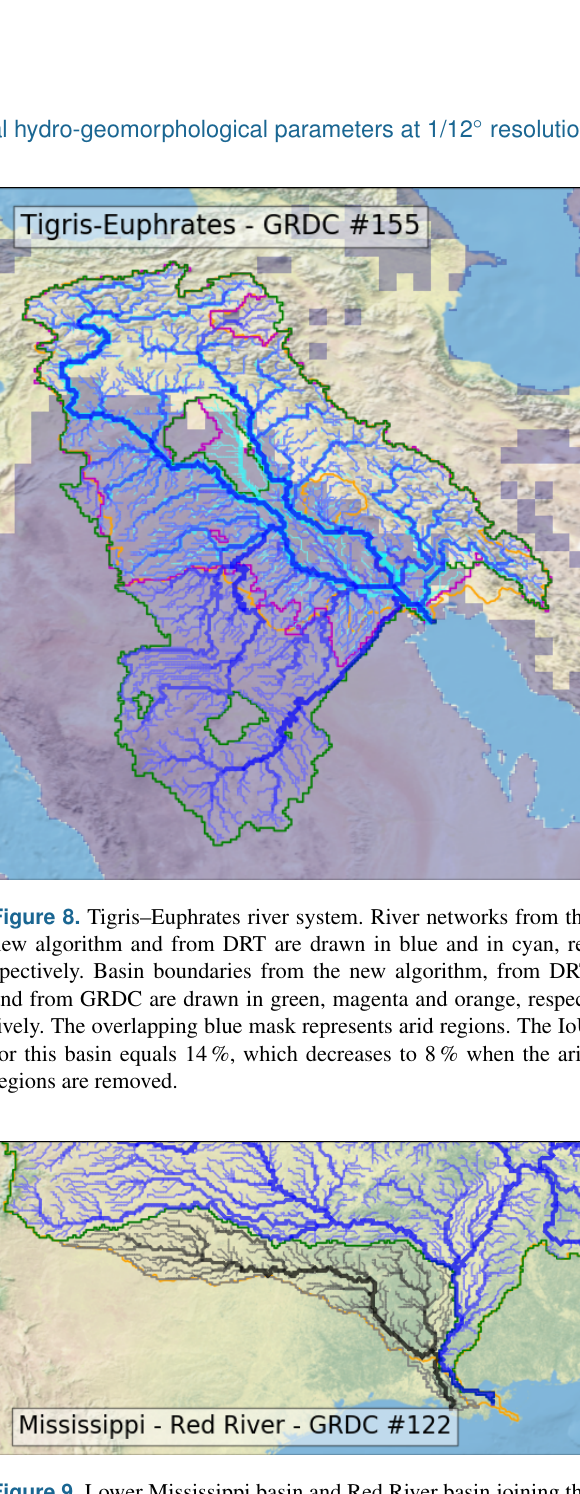
Figure 9. Lower Mississippi basin and Red River basin joining the Mississippi Delta. The Mississippi River network is drawn in blue and the Red River in black, while their boundaries are shown in green and grey, respectively. The orange line represents the basin boundary of the Mississippi River from